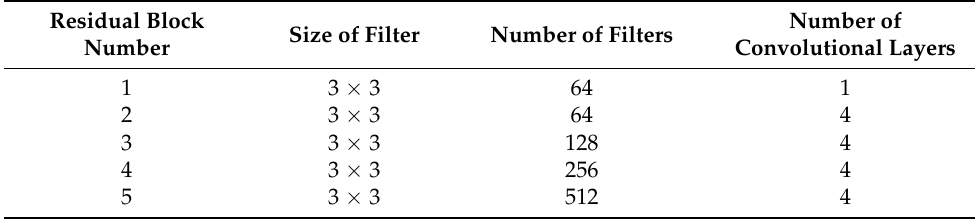
Figure 12. Hardwood, New Tool, 1 mm depth-of-cut. The spectrogram in Figure 13 shows very high energy values because of the worn- out tool.